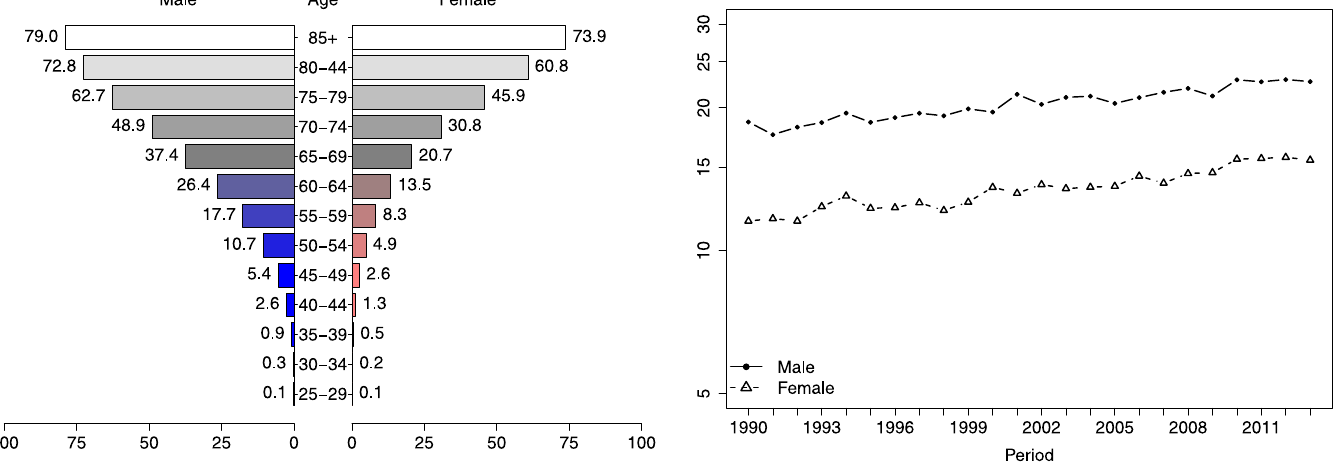
Fig 1. Age-specific mortality rates per 100,000by gender (left), and age-standardized rate trends between 1990–2013by gender on semi- logarithmic scale on the y-axis (right).